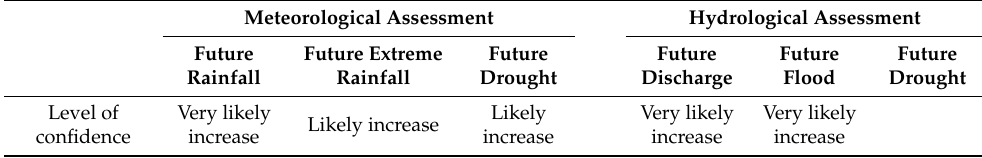
Table 4. Summary of basin-scale annual assessment.